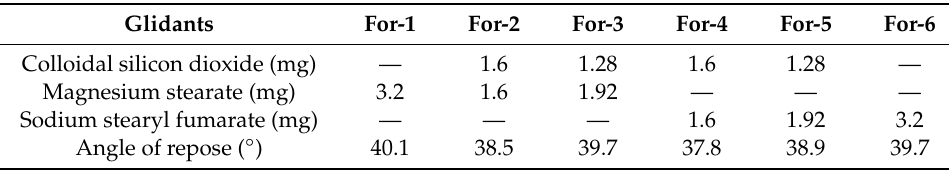
Table 6. The screening results of